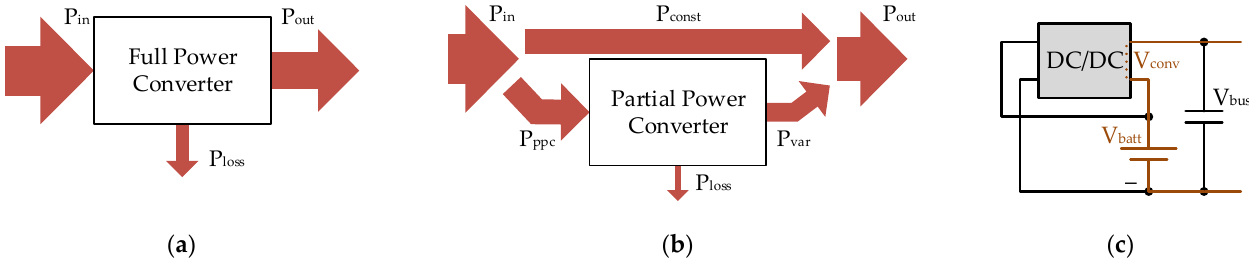
Figure 20. Full power operation vs. partial power operation: ( a ) power distribution in full power converter, ( b ) power distribution in partial power converter, ( c ) diagram showing operation with reduced voltage.